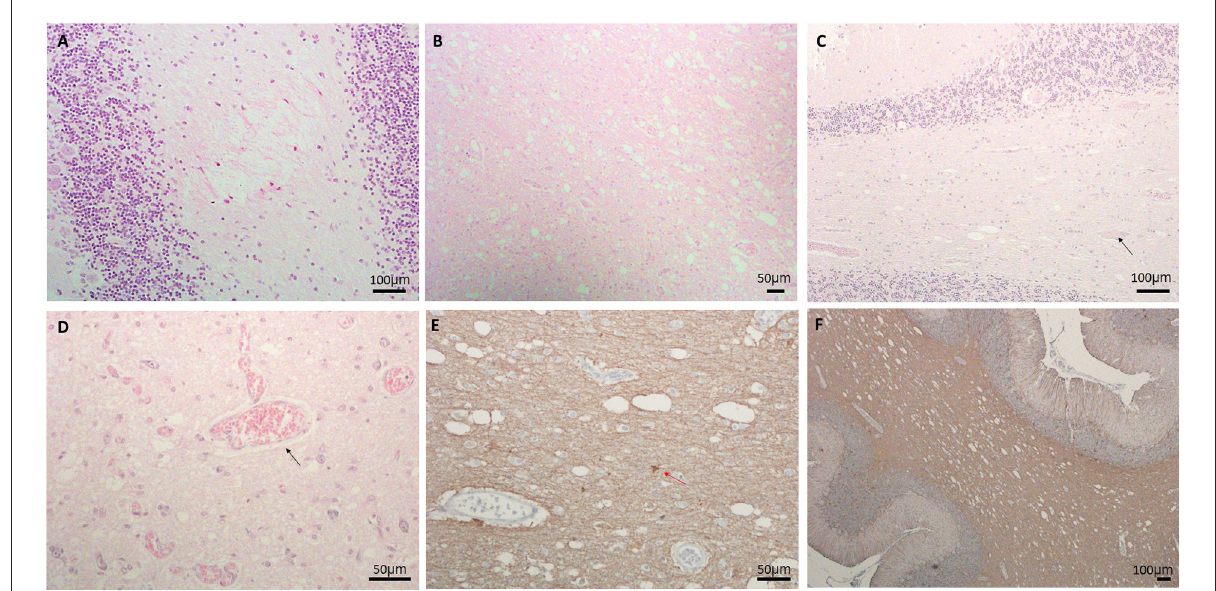
FIGURE1 (A) Neuropil vacuolation in the cerebellar white matter in LS#l, (B) extensive vacuolation, gliosis, and vascular proliferation in pons of LS#2, (C, D) vacuolation, vessels (marked by black arrow) and decreased Purkinje cells in (C) LS#3 and (D) higher magnification of LS#2 showing scattered vessels (black arrow); H&E staining for (A–D) . (E, F) IHC of GFAP showing extensive gliosis with obvious neuropils vacuolation in LS#2 (F) high-magnification shows numerous vessels and reactive astrocytes in LS#3 [red arrow, (E)